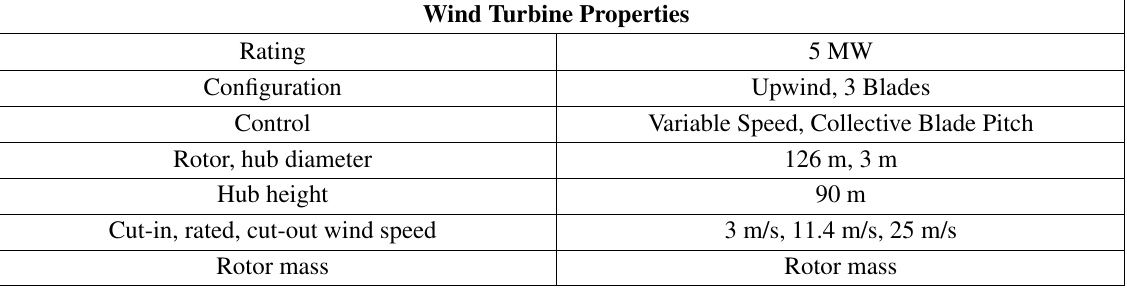
Table 1. NREL 5MW baseline wind turbine gross